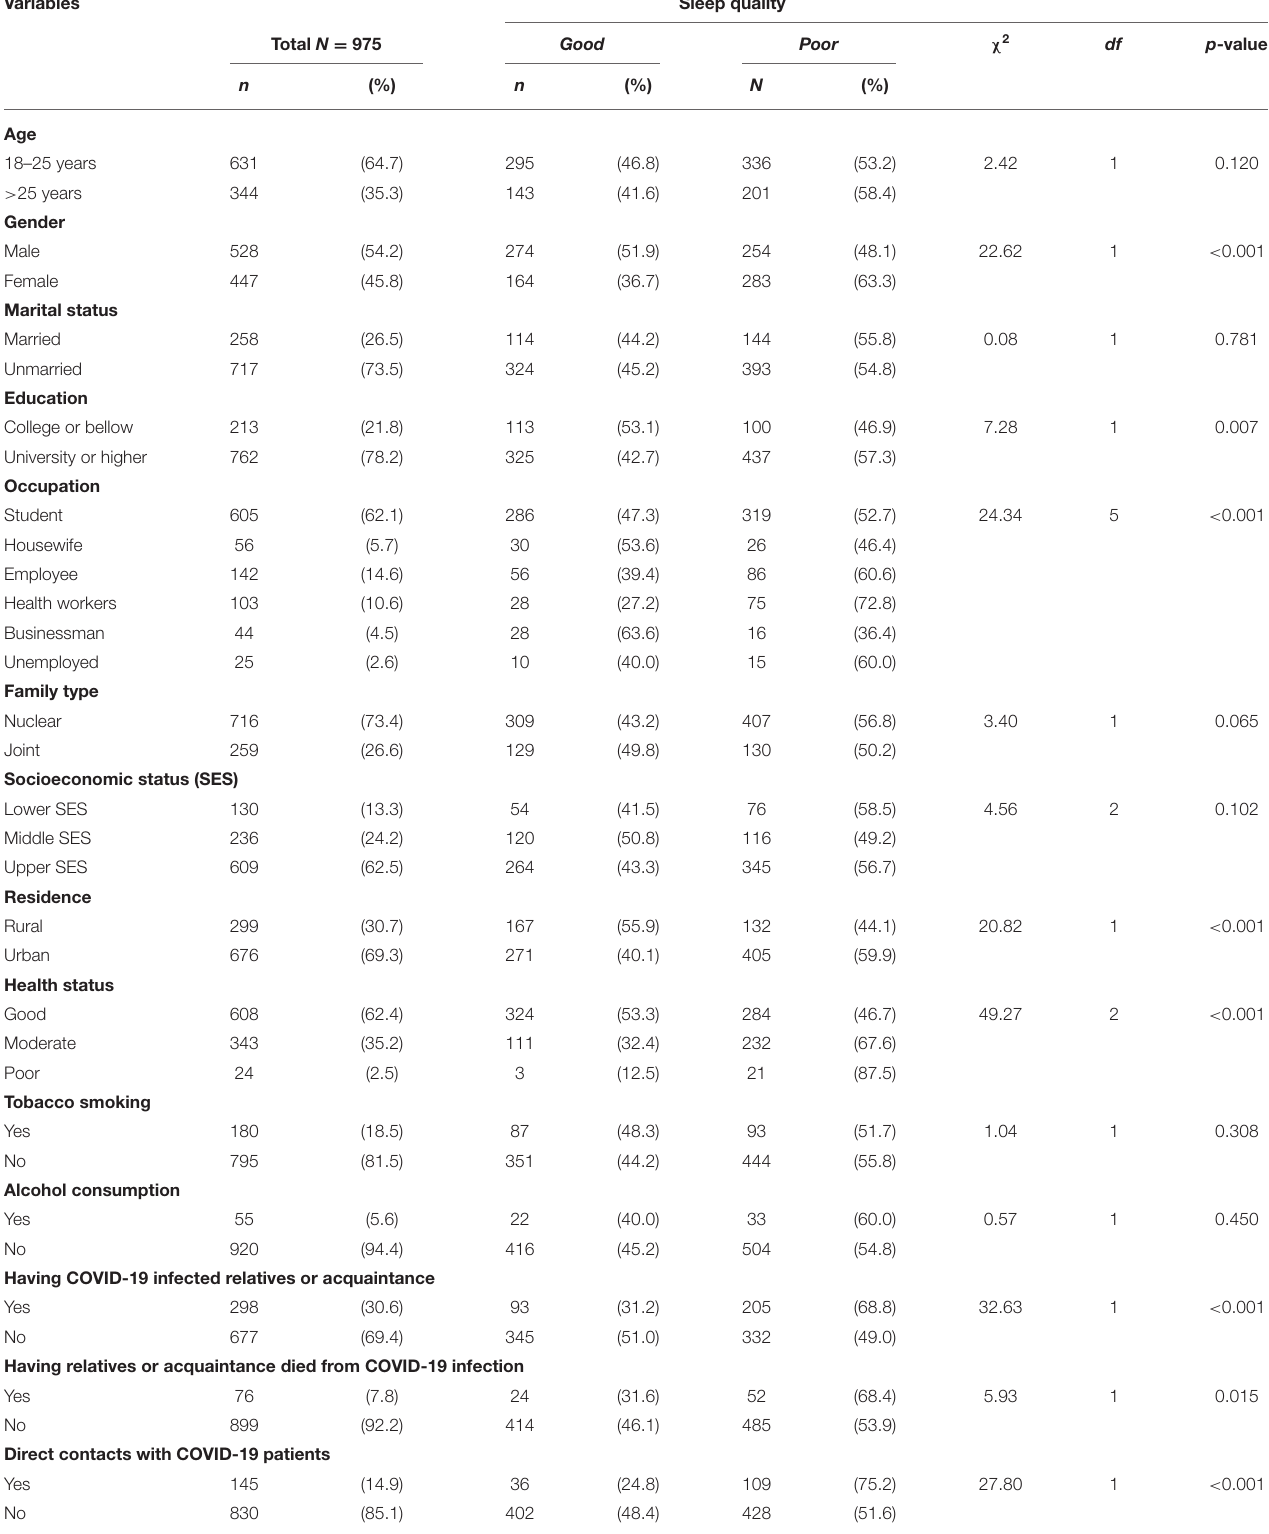
TABLE 1 | Descriptive analyses for all the examined variables with sleep quality ( n =